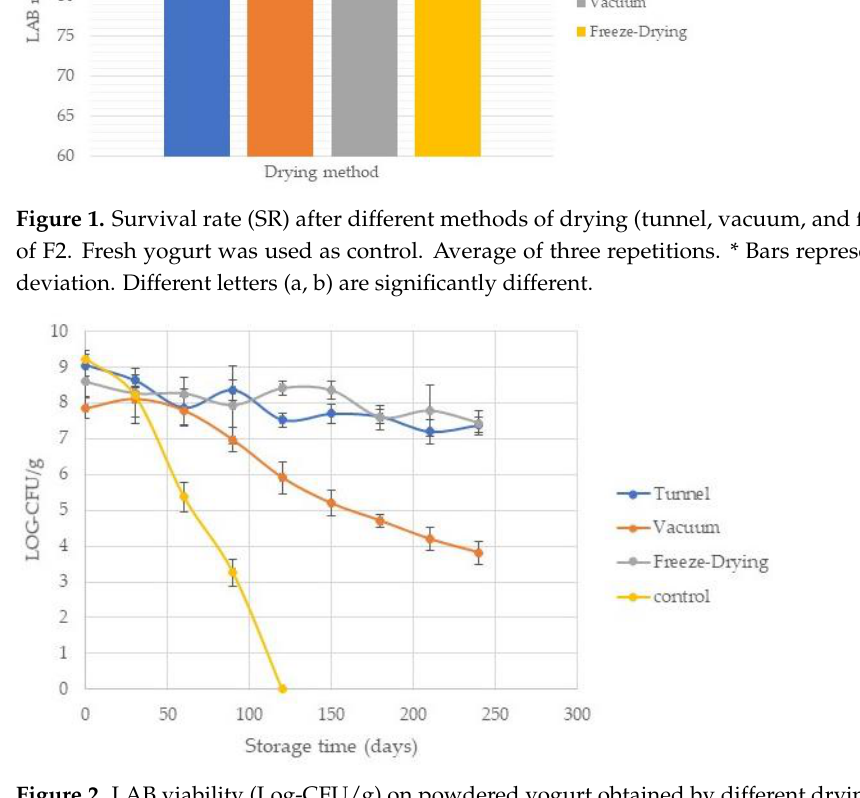
Figure 2. LAB viability (Log-CFU/g) on powdered yogurt obtained by different drying methods as a function of storage time at 20 ◦ C. Fresh yogurt at storage temperature of 4 ◦ C was used as control. Average of mean values of three repetitions ± standard deviation (represented by bars).